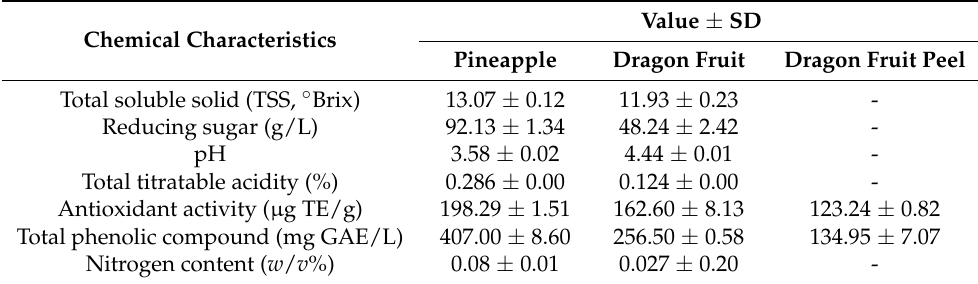
Table 2. Basic chemical characteristics of pineapple and dragon fruit. Chemical Characteristics